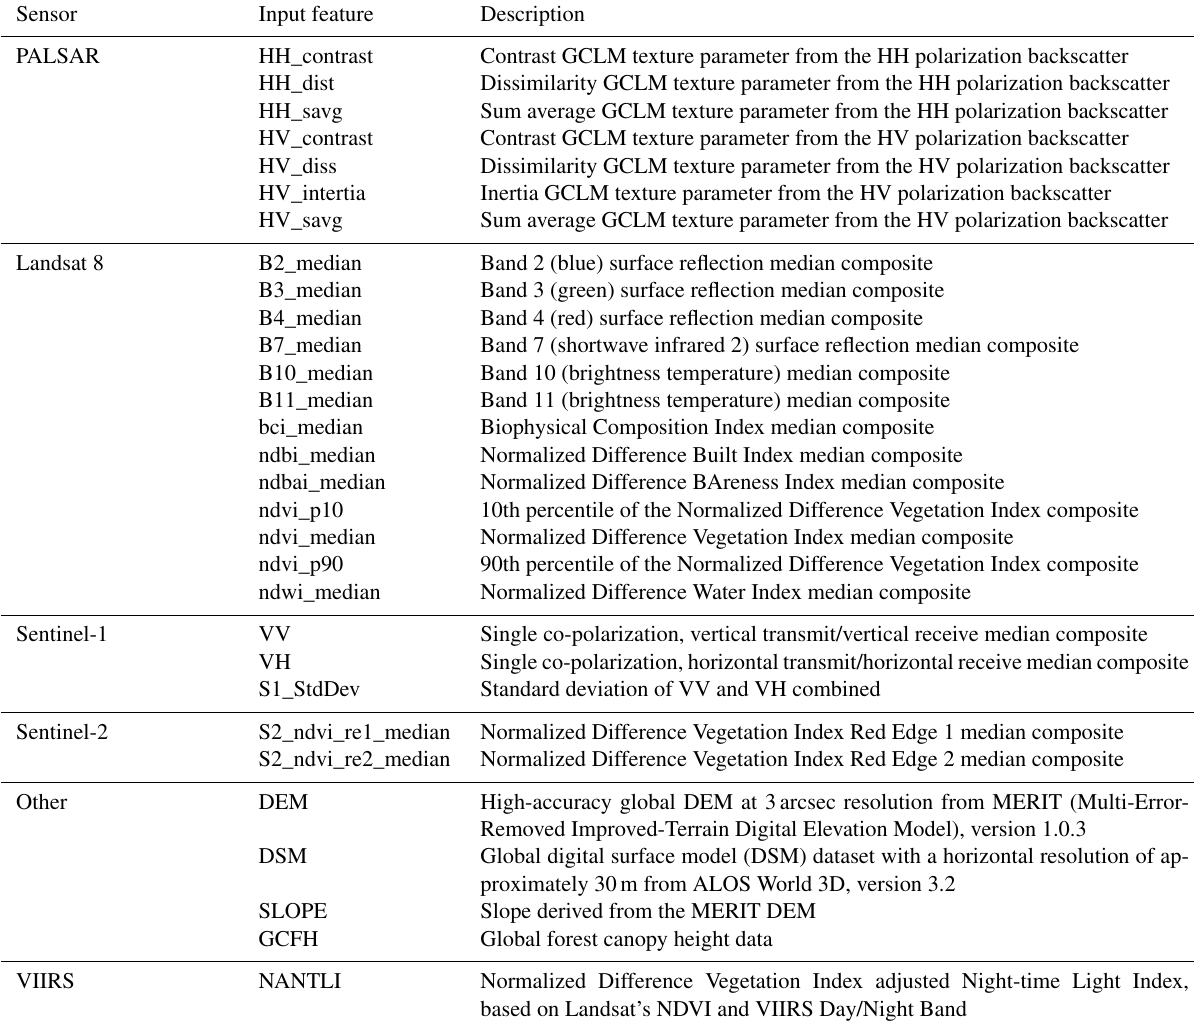
Table F1. Final set of input features used in the global LCZ mapping process. The information is structured by a sensor, with the input feature names referring to the abbreviations used in the feature importance ranking shown in Fig.